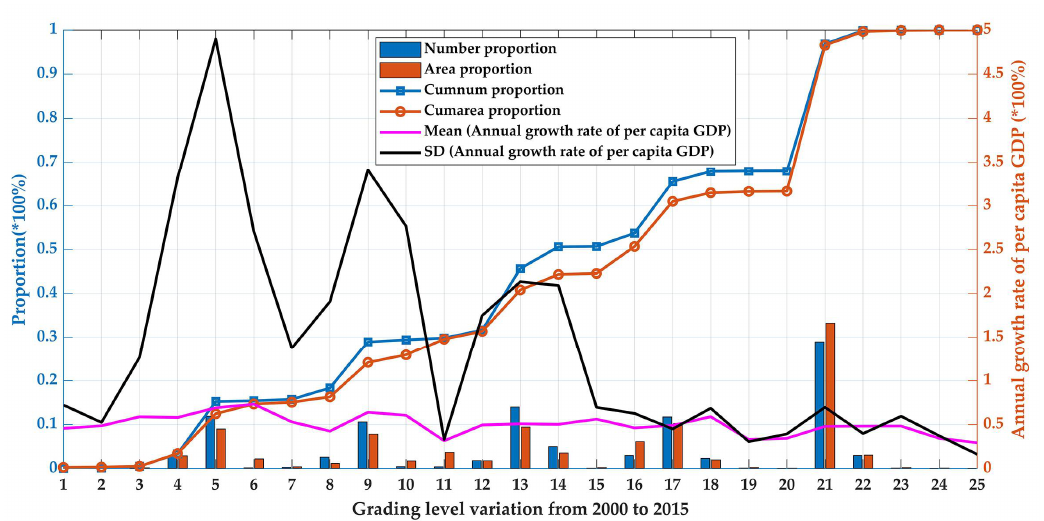
Figure 9. Relationship between the annual growth rate of per capita GDP and the sustainable– development evaluation score.